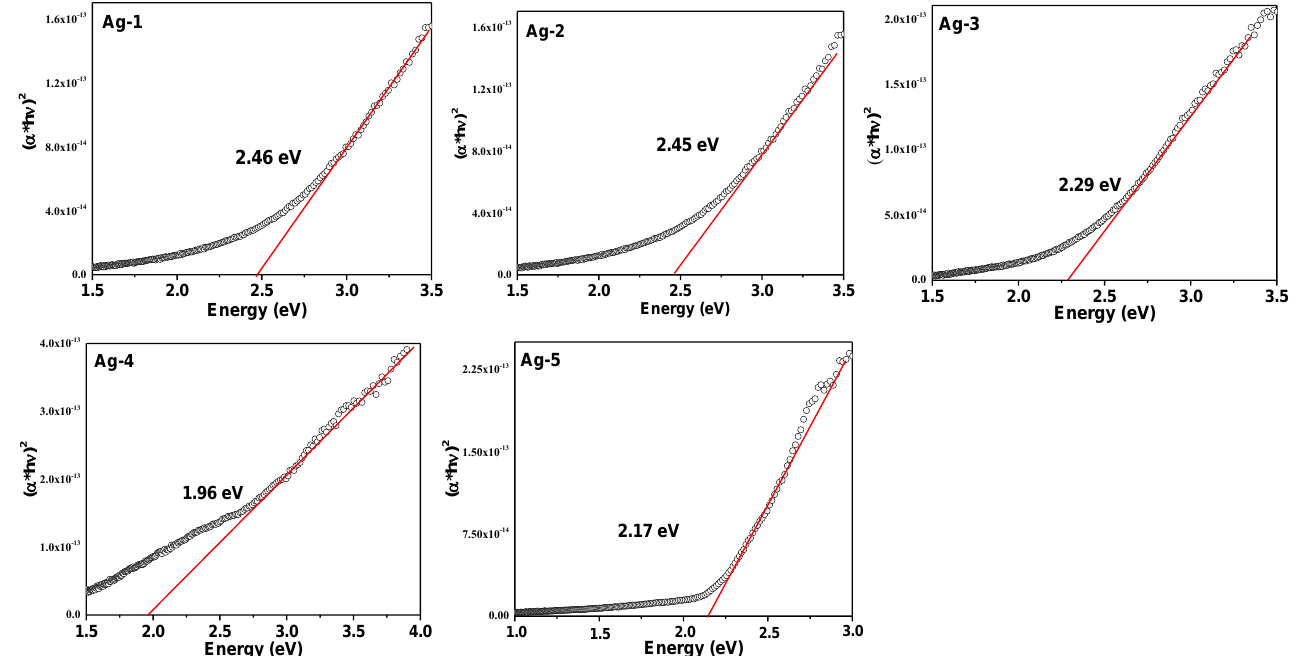
Figure 5. The Tauc plots for synthesized Ag-containing nanomaterials .